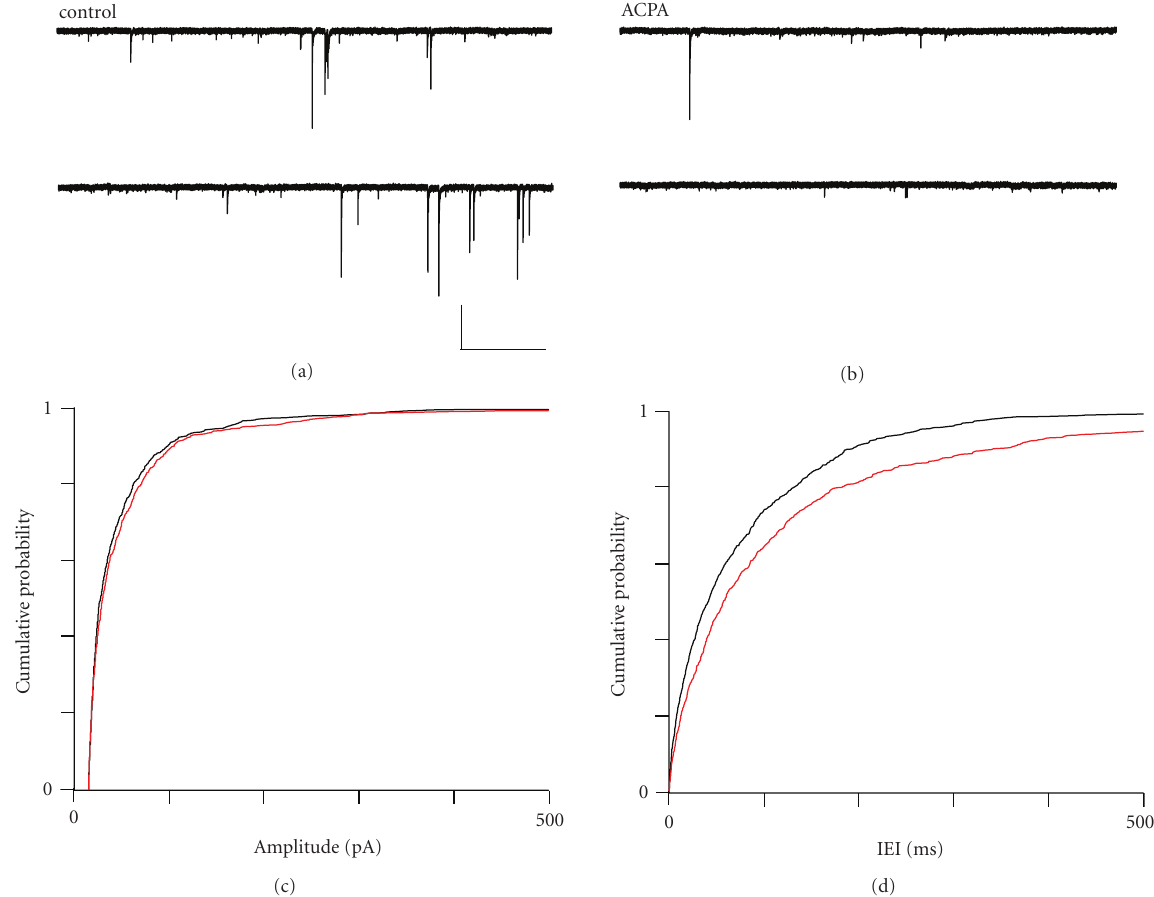
Figure 8: The e ff ects of ACPA on sIPSCs in mEC layer V. (a) Recording from a layer V neurone under control conditions and (b) in the presence of ACPA (500nM). (c) Cumulative probability plot for sIPSC amplitude under control (black) and ACPA (red) conditions. (d) Cumulative probability plot for sIPSC IEI under control (black) and ACPA (red) conditions. Scale bars 2000 milliseconds × 250